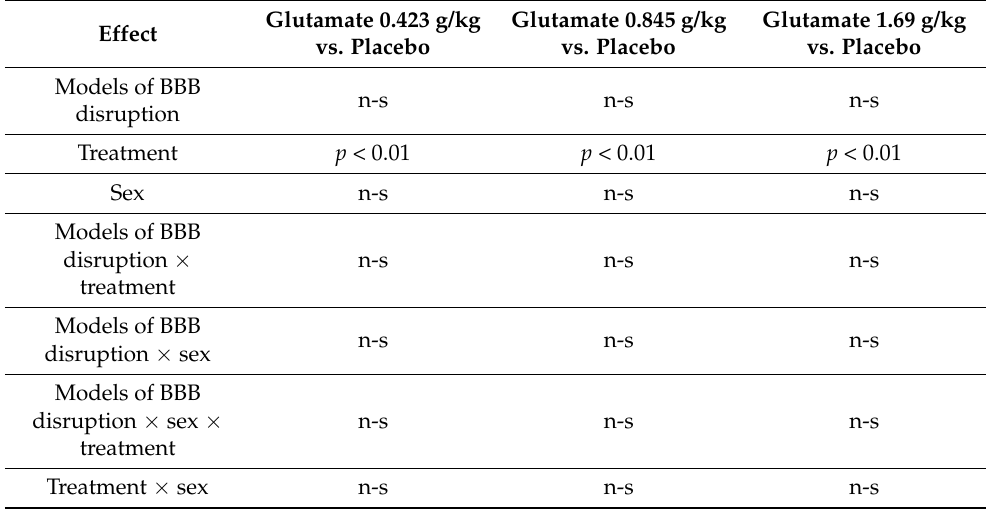
Table 2. Main effects of model of BBB disruption, treatment and sex and their interaction effects on blood glutamate level. No significance